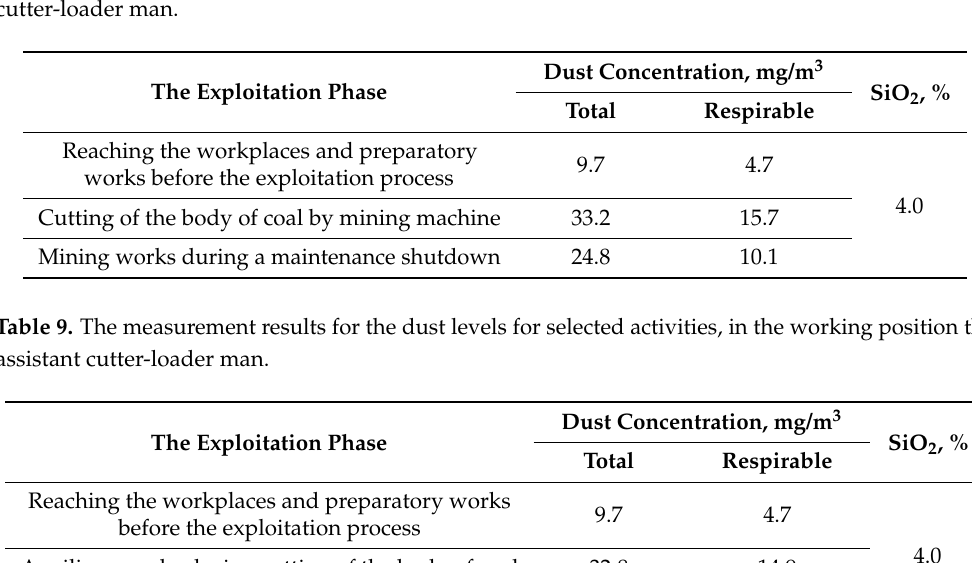
Table 8. The measurement results for the dust levels for selected activities, in the working position the cutter-loader man.